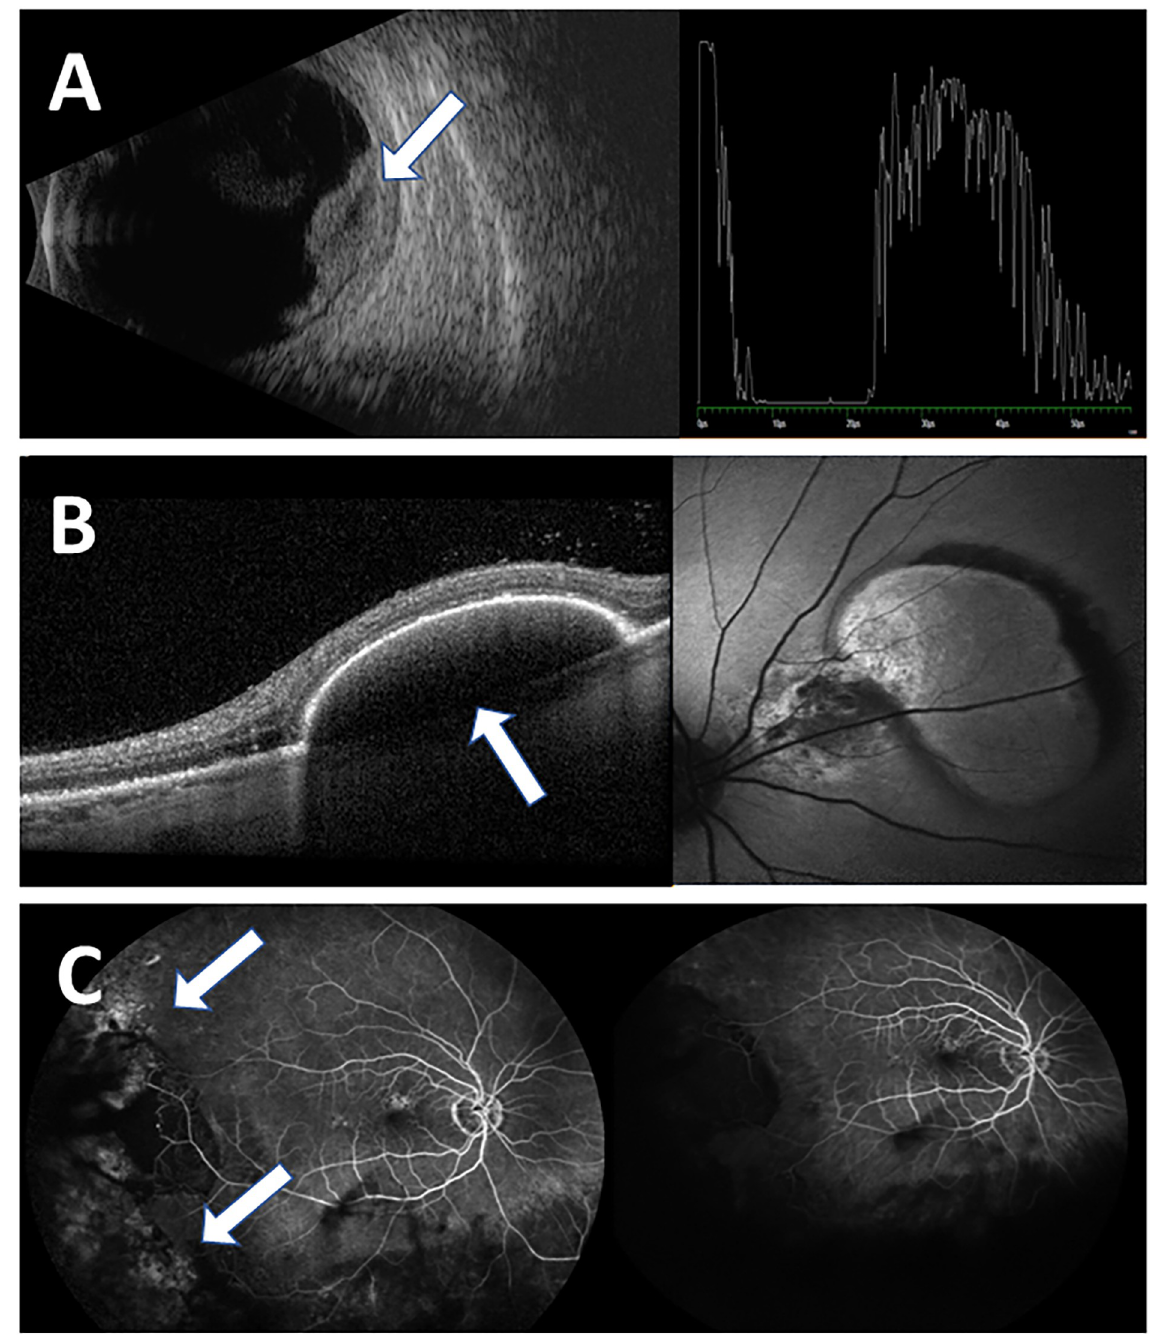
Fig 2. Main imaging findings of PEHCR in our cohort. The imaging modalities used for evaluation and follow-up of our patients included mostly ultrasound (US) and optical coherence test (OCT), in addition fluorescein angiography (FA) and Indocyanine Green Angiography (ICGA) in several patients. A , US image, depicting a choroidal mass (B-scan right side) with a high internal reflectivity (A-mode left side, arrow); B , The most common finding at presentation on OCT was PED (30%) (arrow) C , FA imaging reveals mostly hyperflourescent lesions (arrows) (55.56%), with no evidence of